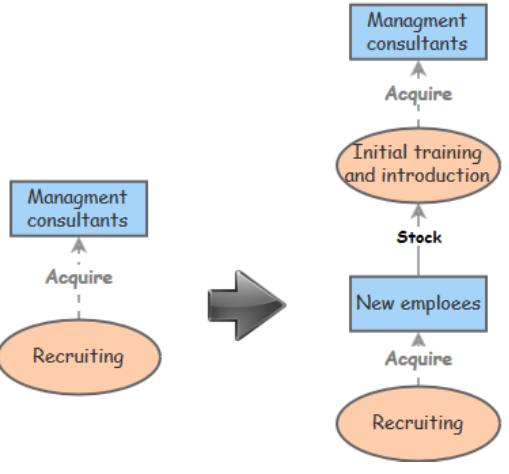
Figure 3. More detailed FEM fragment for acquiring new workforce